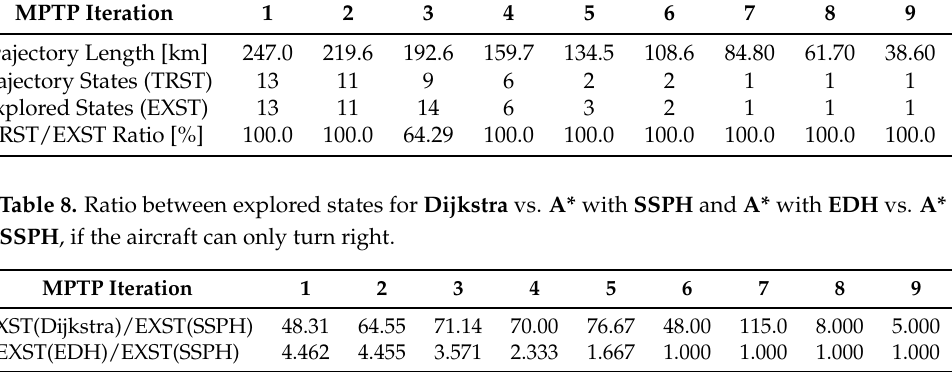
Table 7. A* with SSPH applied to the avoidance in Figure 11, if the aircraft can only turn right. MPTP Iteration Trajectory Length [km] Trajectory States (TRST) Explored States (EXST)